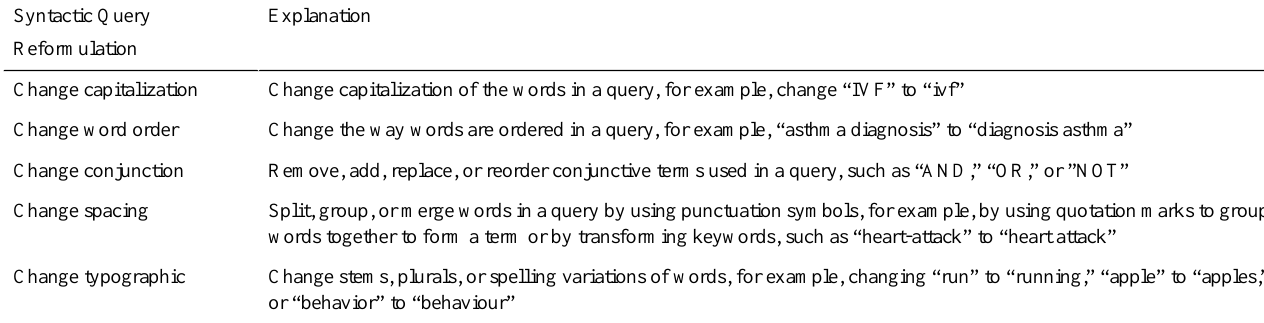
Table 2. Examples of syntactic query